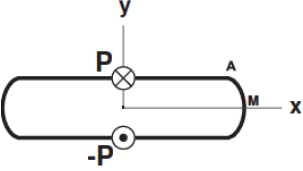
Figure 1: Slot boundary and loads